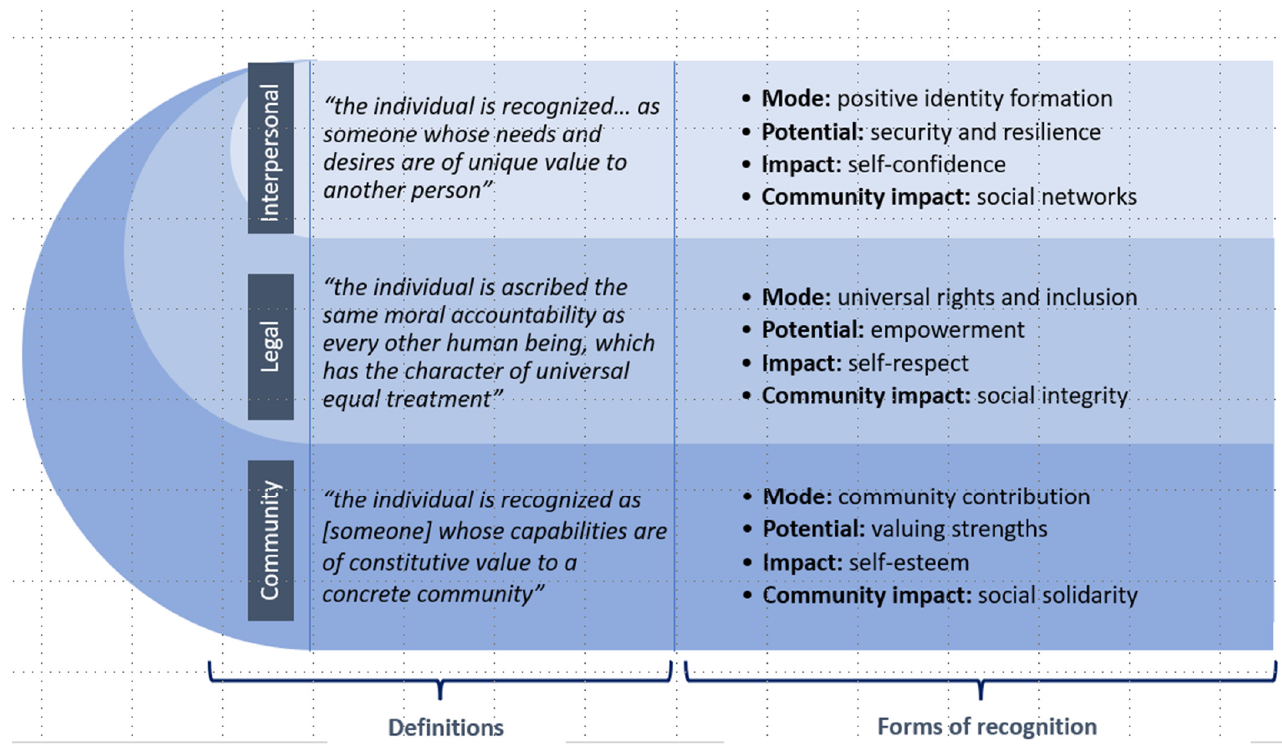
Figure 1. Honneth’s Recognition Theory: A tripartite framework of interconnected forms of interpersonal, legal and community recognition [34] (pp. 26–29).